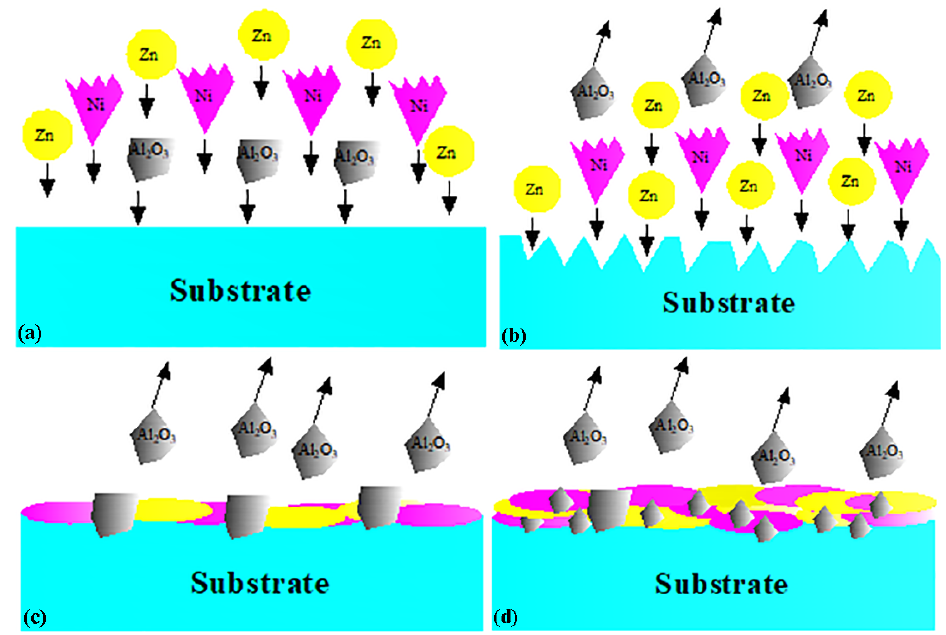
Figure 5. Deposition process of metal (Zn, Ni particles) and ceramic (Al 2 O 3 particles) with LPCS